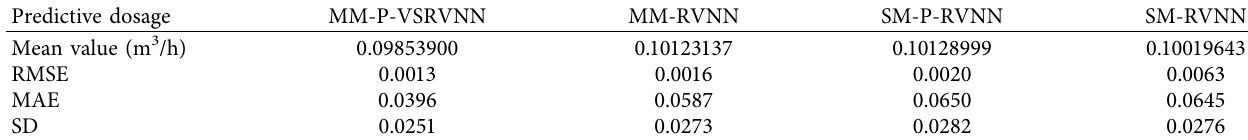
Table 4: Statistics result comparison among four algorithms for predictive dosage before filtration. Predictive dosage